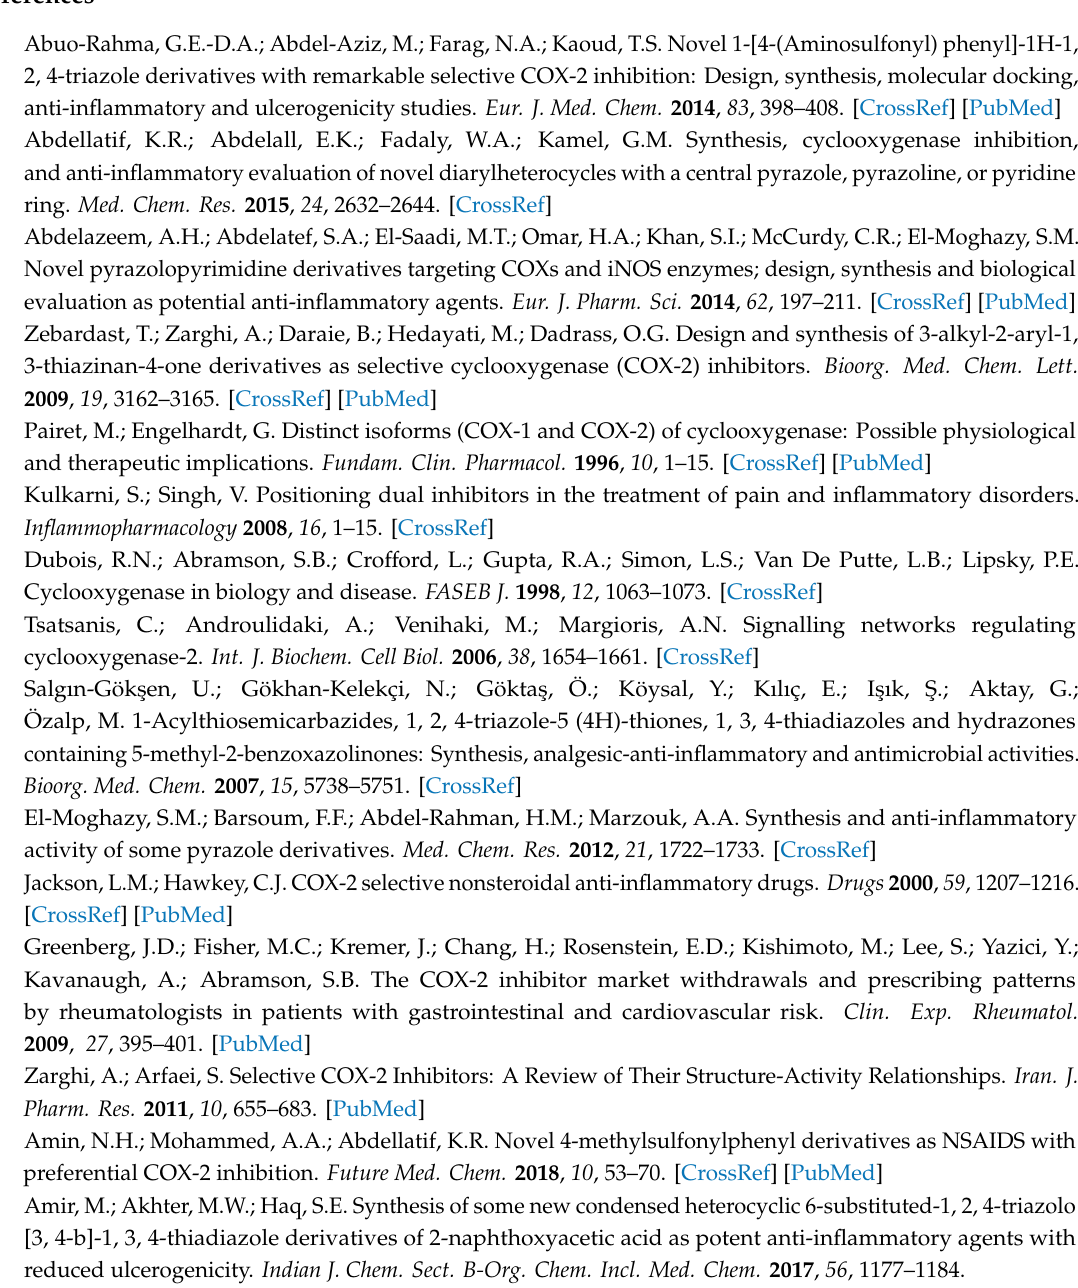
12a . Figure S20. 1H-NMR spectrum of compound 12b . Figure S21. 1H-NMR spectrum of compound 12c . Figure S22. 1H-NMR spectrum of compound 12d